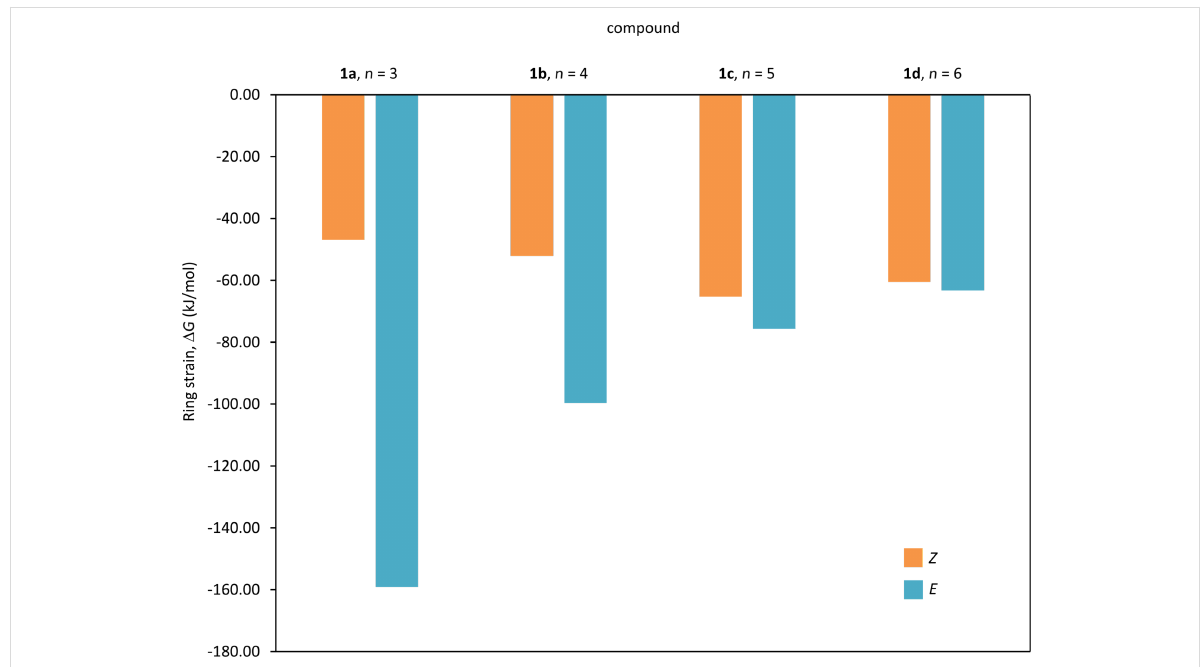
Figure 4: Ring strain for E and Z -isomers of 1a – d expressed as the Gibbs free energy difference to an acyclic analogue, using an isodesmic reaction (Figure S47, Supporting Information File 1).